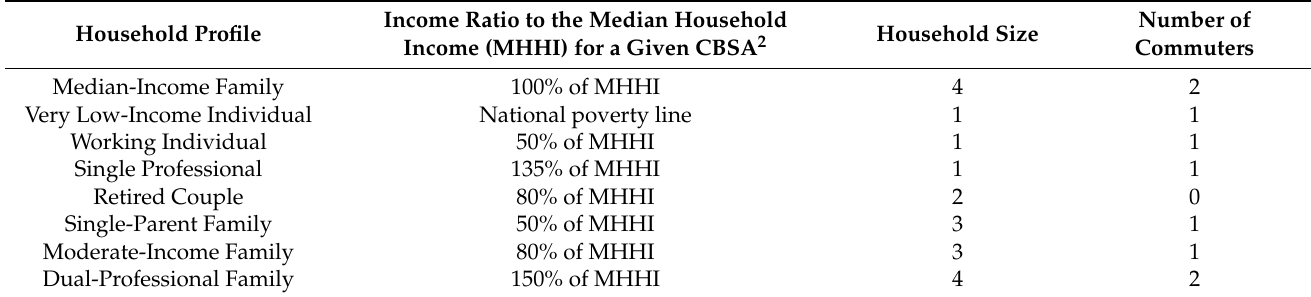
Table 1. Type of households in the Location Affordability Index (LAI).